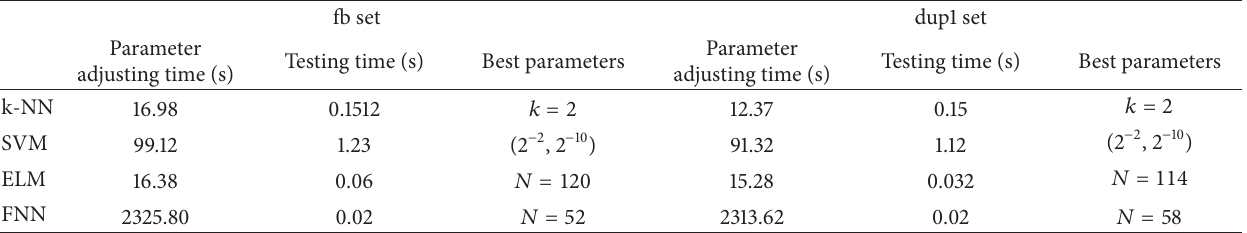
Table 8: Comparison of parameter adjusting time and testing time of k-NN, FNN, SVM, and ELM: the color FERET database. fb set dup1 set Parameter Testing time (s) Best parameters Testing time (s) Best parameters adjusting time (s)